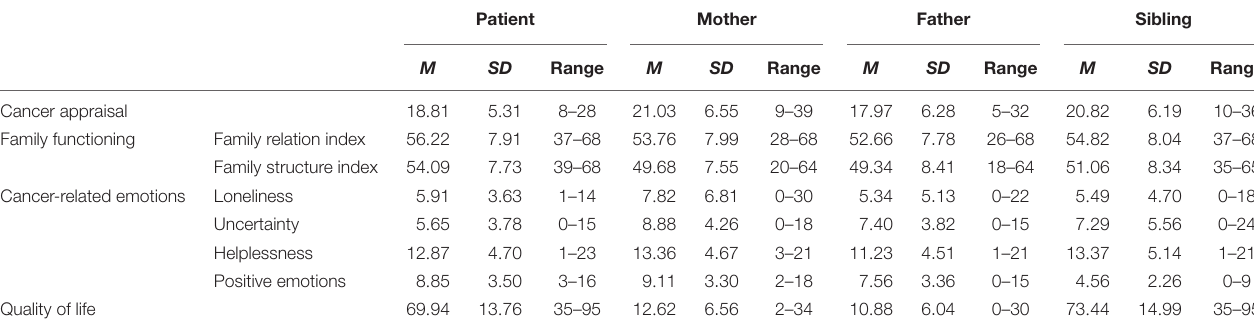
TABLE 2 | Descriptive statistics of the study